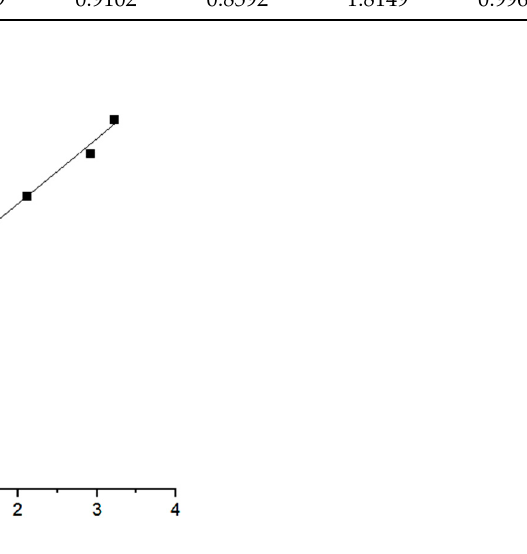
Figure 10. Langmuir isotherm for the removal of Pb(II) ions from aqueous solution by Si-TS-SSIL.